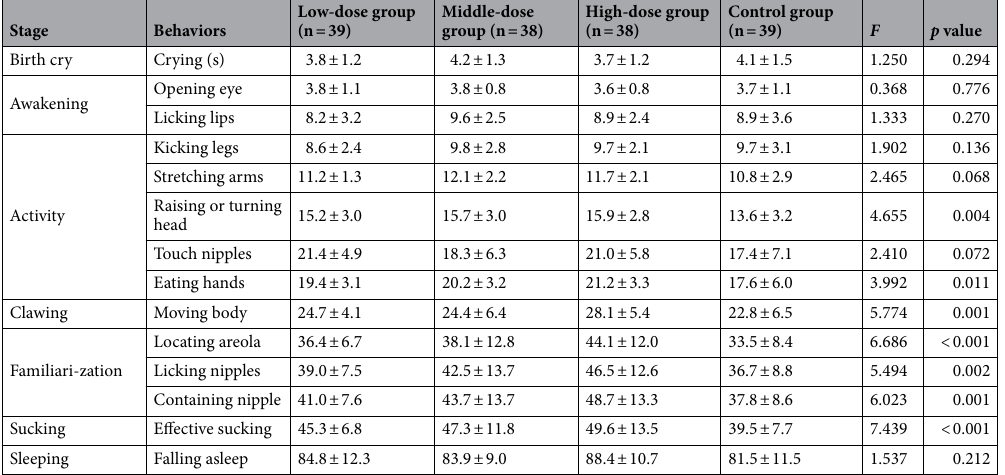
Table 3. Occurrence time of newborn breastfeeding behaviors (min). The neonates in the relaxation and rest stages did not have any significant movements, which are not listed in the table.